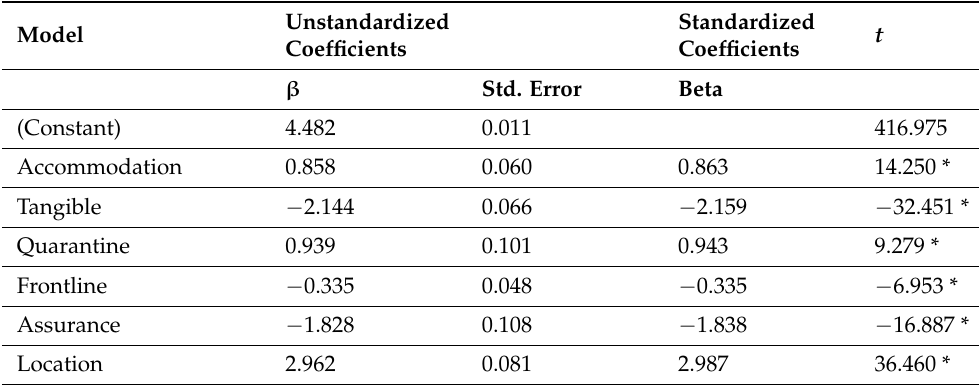
Table 8. Result of linear regression